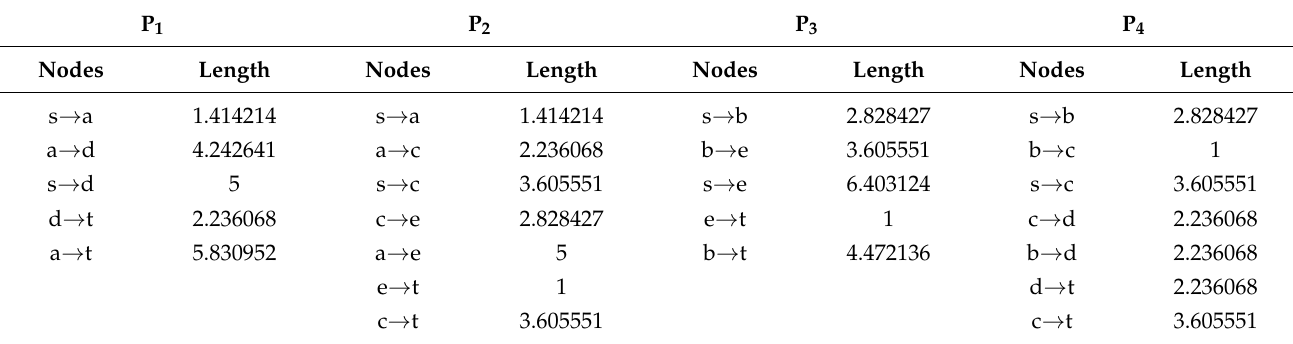
Table 3. Length between nodes of each